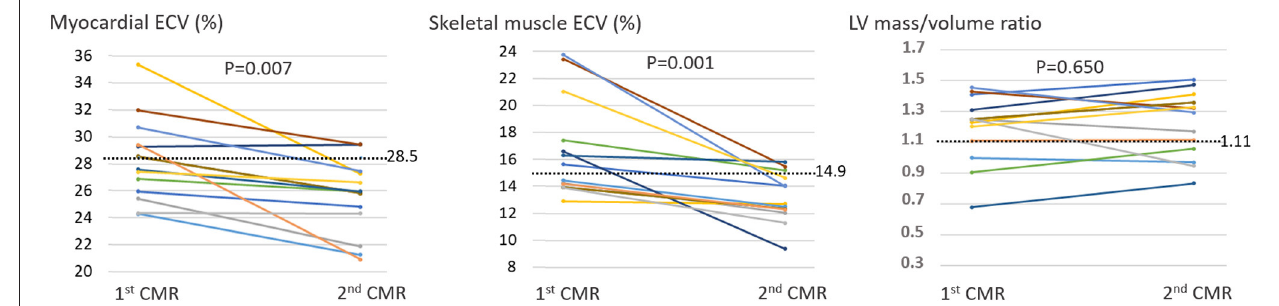
FIGURE 2 | Individual variations between the 1 st and 2 nd CMR for the ECV from the myocardium and skeletal muscles, as well as for the LV mass/volume ratio, which was used to assess LV concentric remodeling and normalized to male values (i.e., with the values in women increased by 0.21 to compensate for the difference in the normal upper limits between women (0.90) and men (1.11)). The dashed lines represent the normal upper limits.